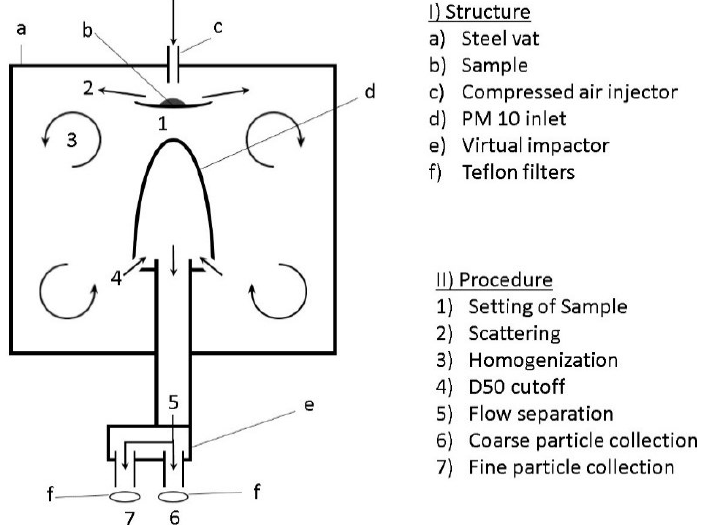
Figure 1. Structure of the resuspension chamber, including the dichotomous sampler, and the procedure for collecting the material on the filters.